Question: Describe this figure in one sentence.
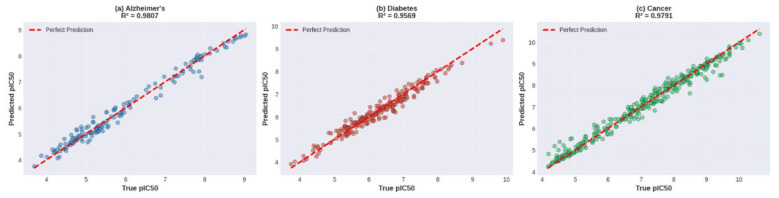
Answer: Predicted vs. true pIC50 scatter plots for (a) Alzheimer's, (b) Diabetes, and (c) Cancer.